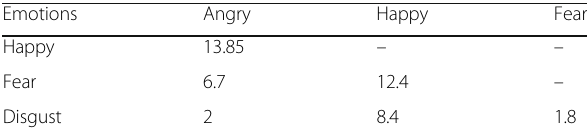
Table 7 Confusion degree between angry, happy, fear, and disgust (%) Emotions